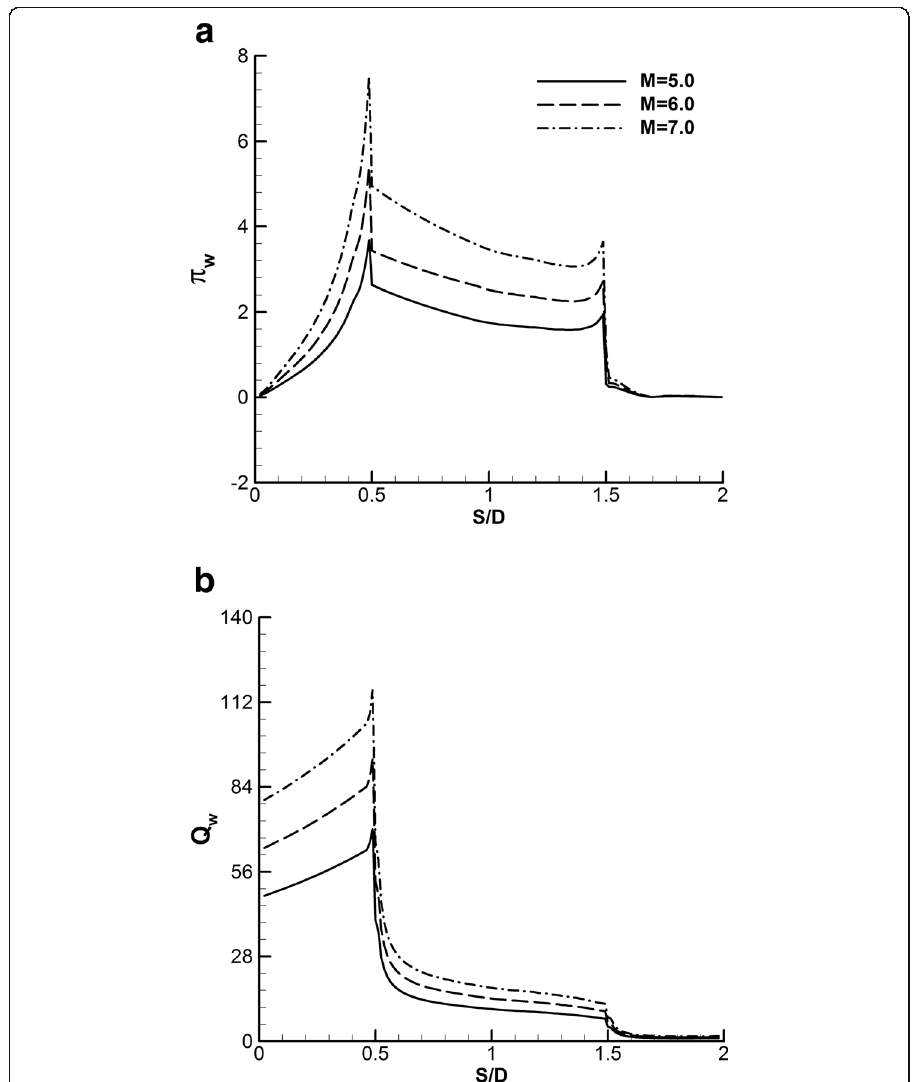
Fig. 7 Comparison of normalized quantities measured on the surface of the square cylinder for different Mach numbers (5, 6, and 7) at Kn = 0.005: a shear stress, and b heat